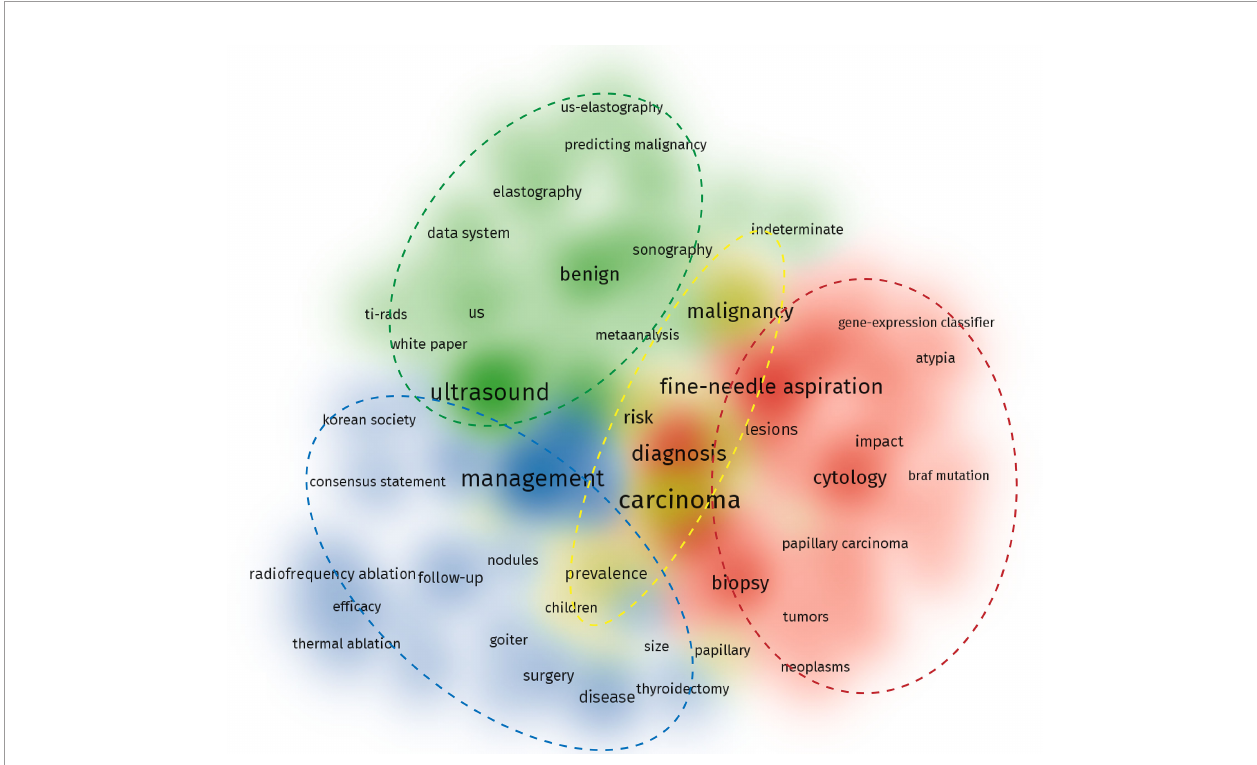
FIGURE 3 | Topic clusters sorted by VOSviewer: Red, fi ne-needle aspiration and cytology in the diagnosis of TNs; green, ultrasound and benign features of TNs; yellow, thyroid carcinoma and malignancy of TNs; and blue, treatment and management of TNs. The gradation of circle colour represents the number of publications for each topic.